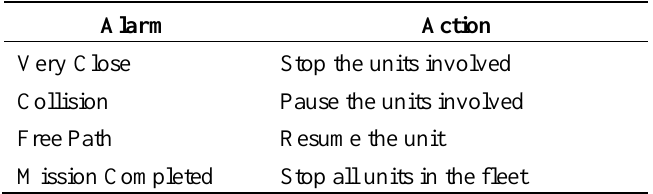
Table 5. Alarms and actions associated with the Fault Recovery